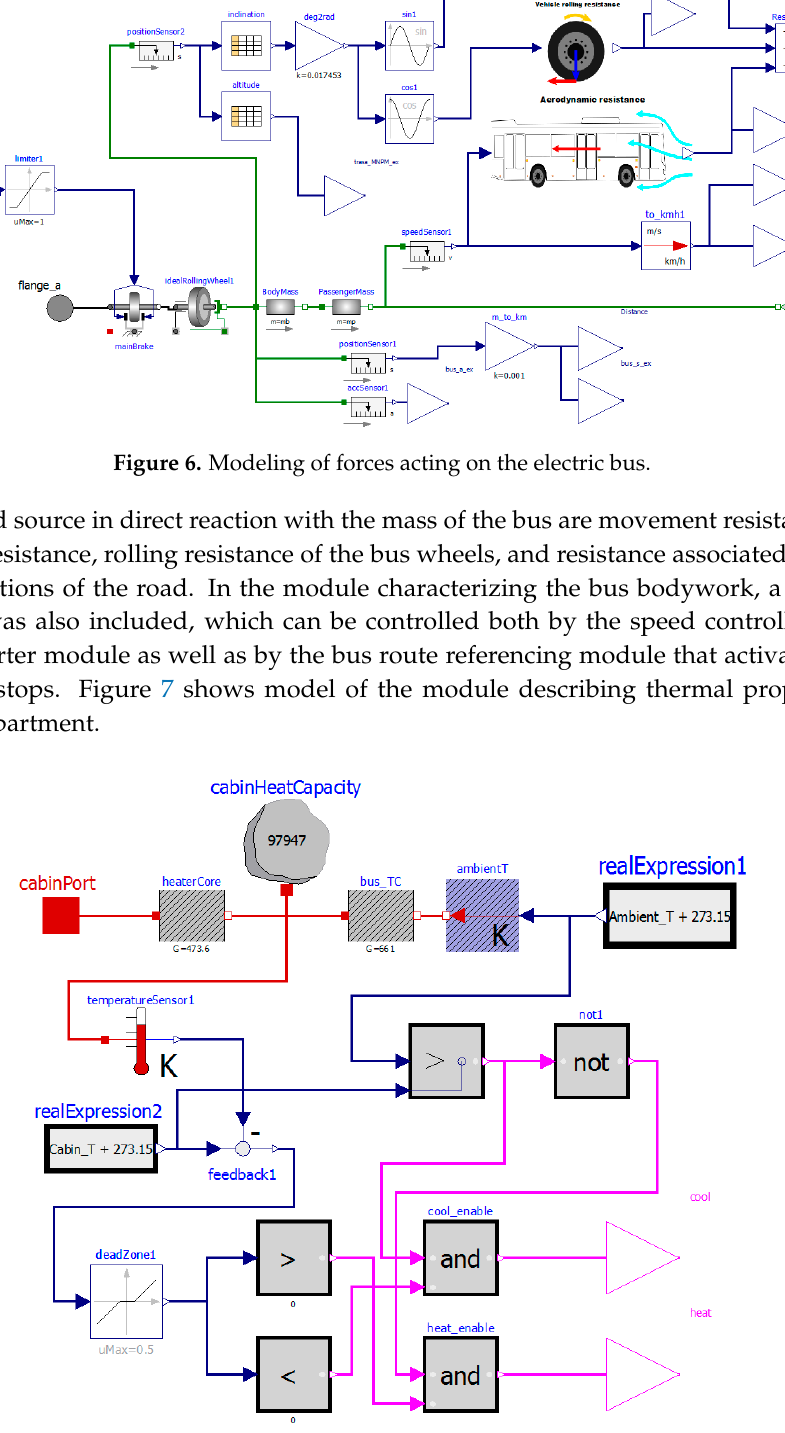
Figure 7. Modeling of the thermal conditioning system of the passenger compartment.